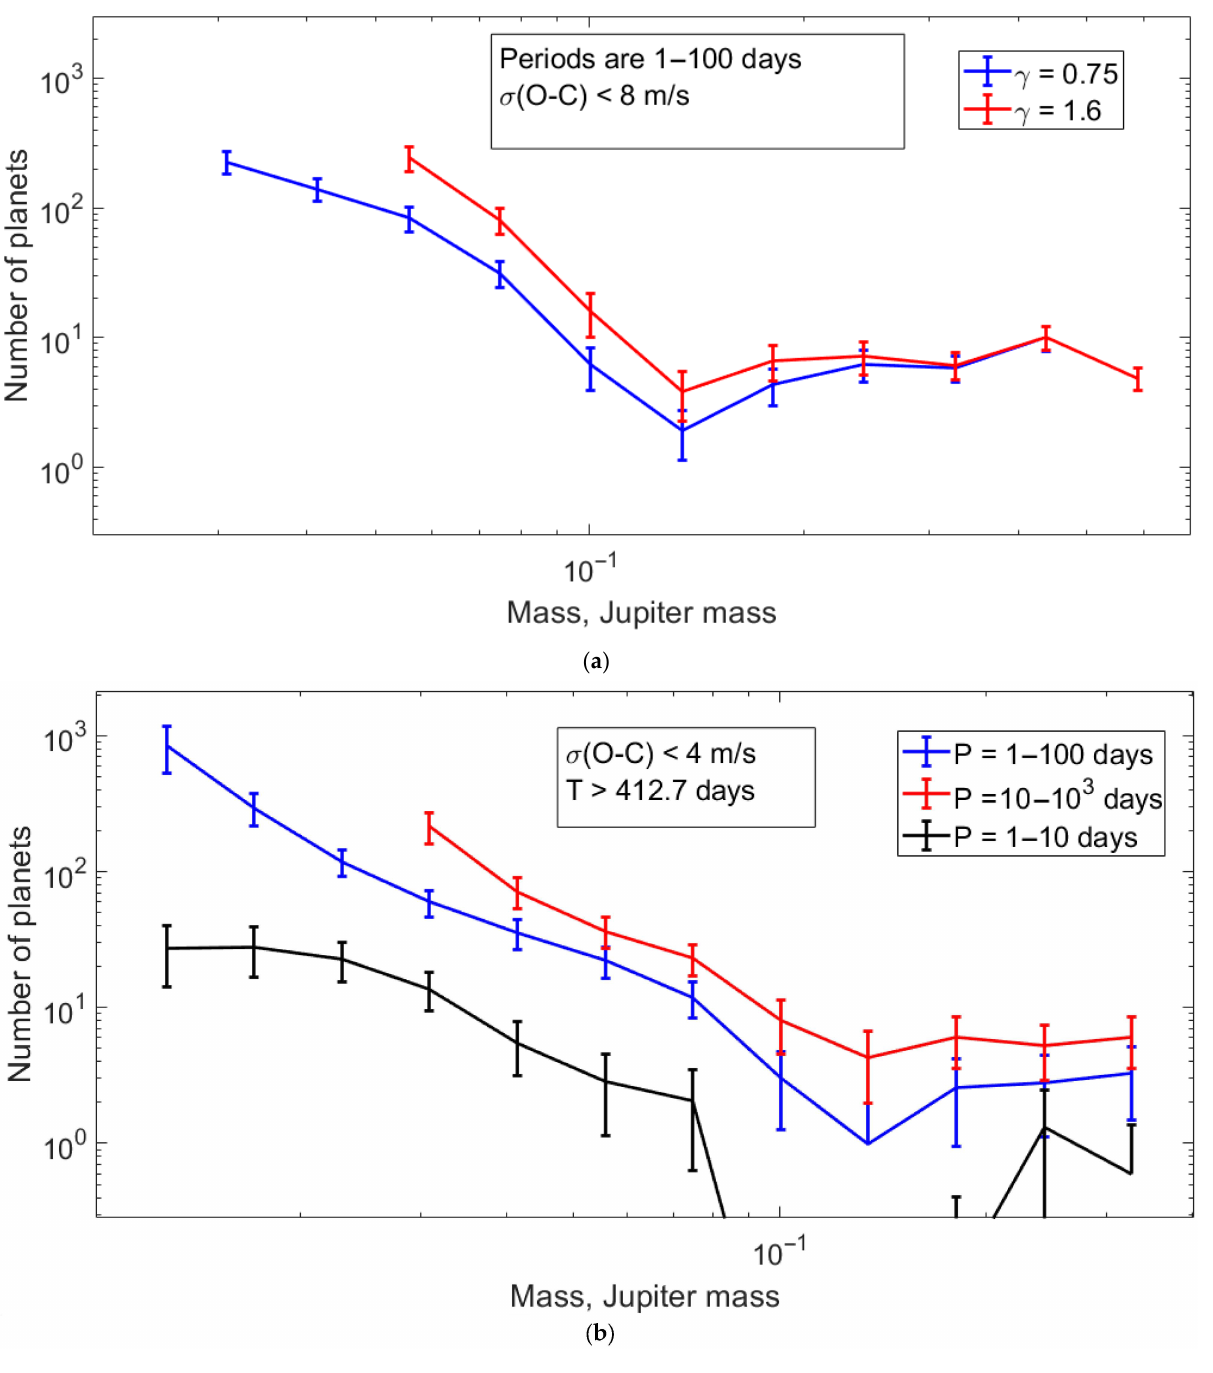
Figure 7. ( a ) The de‑biased mass distributions of planets with masses m = (0.036–0.38) M J and orbital periods P = 1–100 days for γ = 0.75 and 1.6. The planets with σ (O − C) < 8 m/s are considered. ( b ) The de‑biased mass distributions of the planets having the orbital periods of 1–100 days (blue line), 10–1000 days (red line), and 1–10 days (black line). The planets of low‑noise systems (with σ (O − C) < 4 m/s) are considered. By guess, the minimum is caused by planets in tight